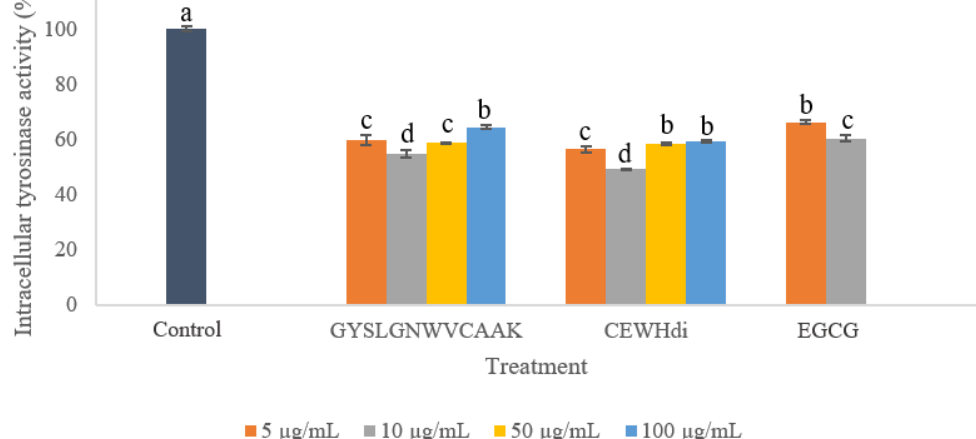
Figure 3. Effects of various concentrations of GYSLGNWVCAAK, CEWH di and EGCG on the intracellular tyrosinase activity of B16F10 melanoma cells. Note: Results were reported as the mean ± standard deviation ( n = 3); different lowercase letters above the bars indicate significant difference at p < 0.05 according to Duncan’s test.